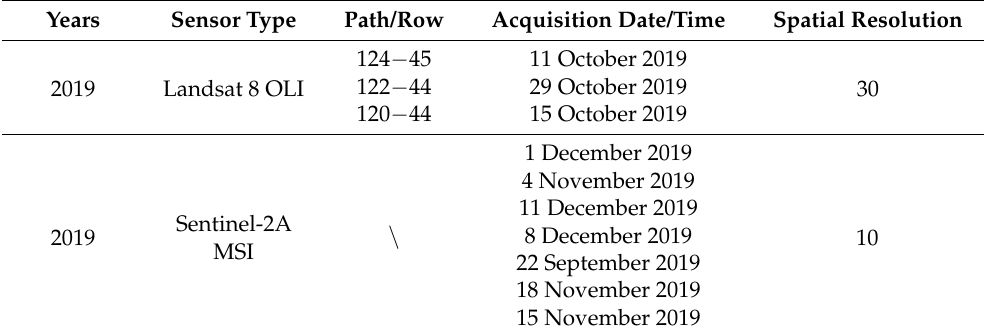
Table 1. Dataset information about the collected Landsat 8 OLI and Sentinel-2A MSI